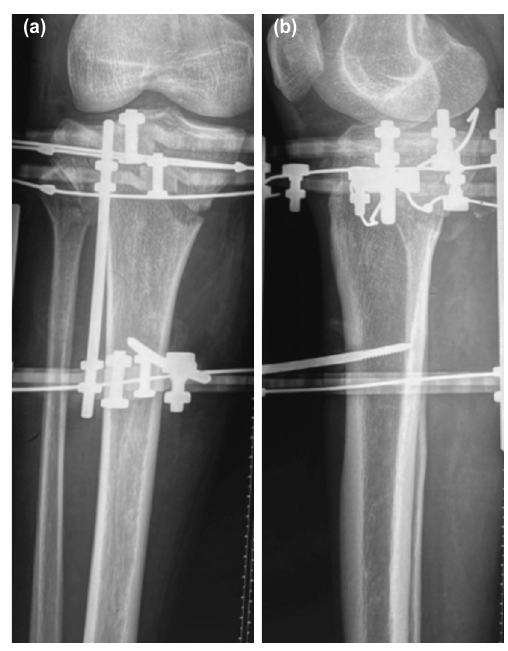
Case No.12, radiographs at final follow up showing Fig. 8: union. (a) Antero-posterior view. (b) Lateral